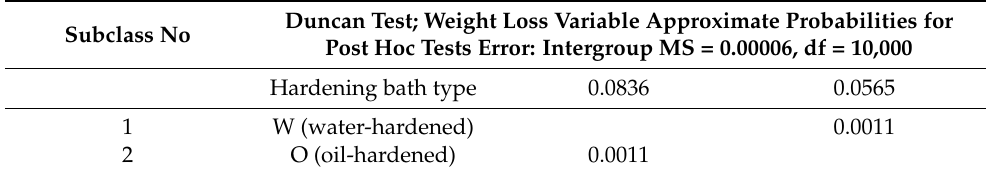
Table 11. The results of variance analysis of Vanadis 60 SuperClean steel wear value in the light soil. Duncan Test; Weight Loss Variable Approximate Probabilities for Subclass No